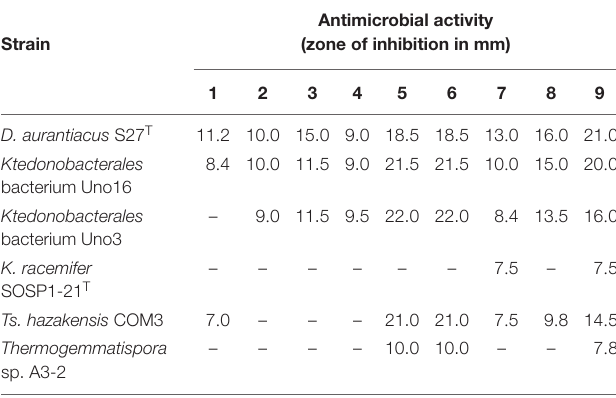
TABLE 4 | Antimicrobial activity of the representative Ktedonobacteria strains assessed using the paper disc method.